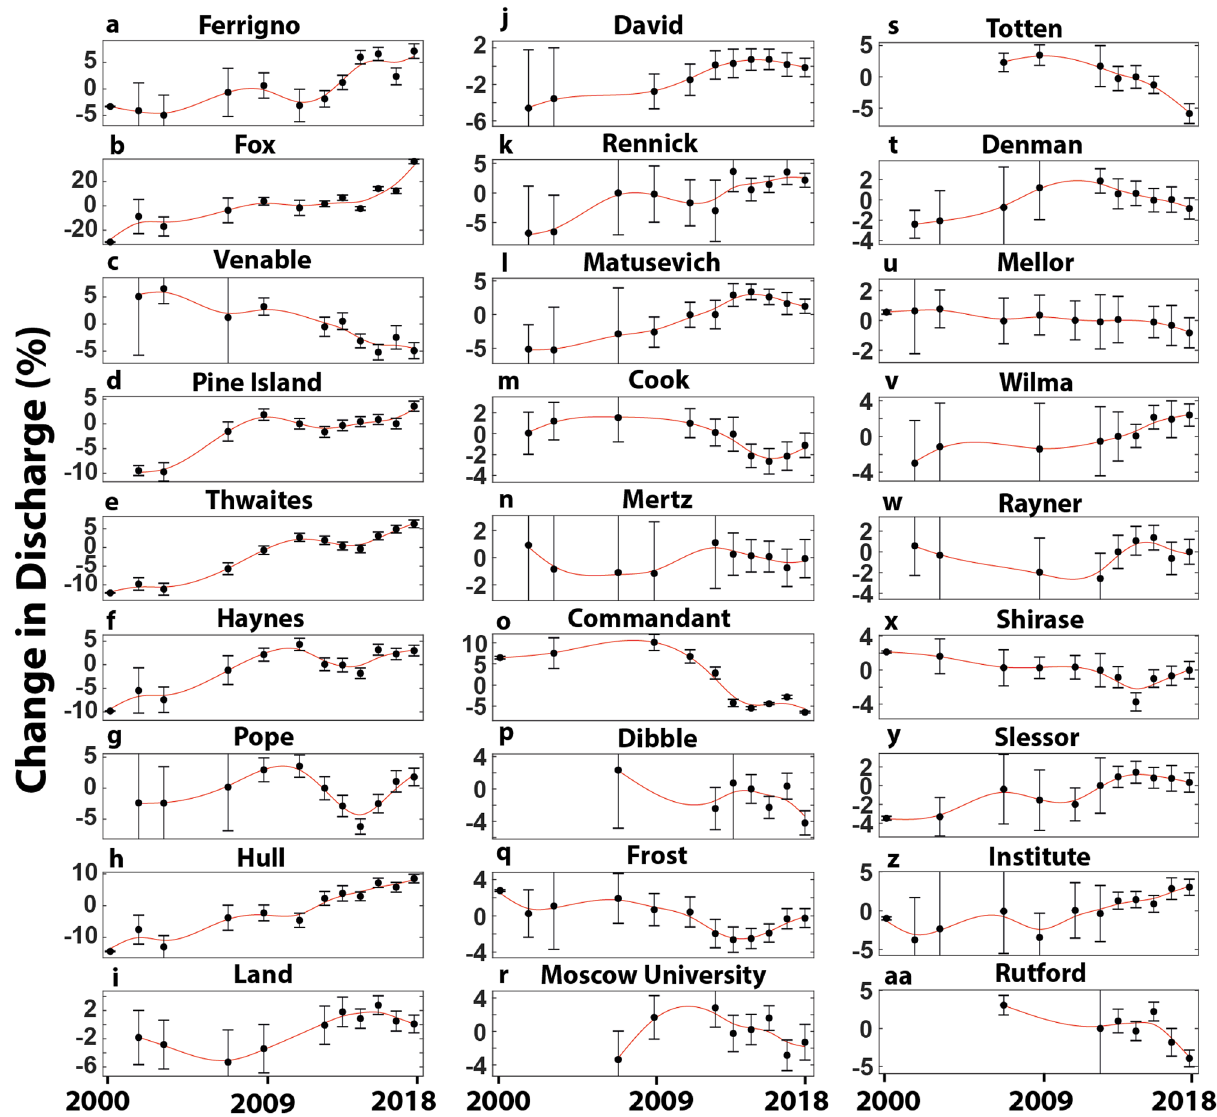
Figure 4. Time series of percentage change in ice discharge rates relative to the mean for selected catchments in West and East Antarctica (note different scales on the y -axes). Data for all catchments is available in the Supplementary